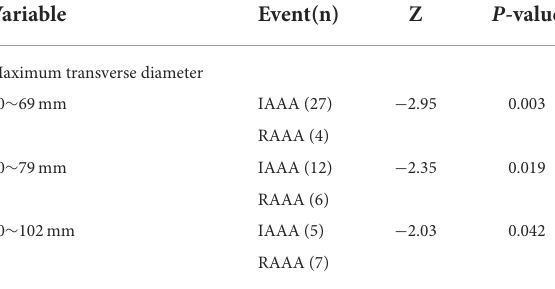
TABLE 3 The differences of maximum CT values at different transverse diameter ranges in the RAAA and IAAA